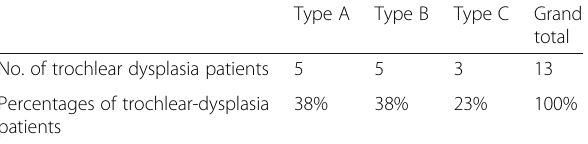
Table 10 Demonstrating the percentage of the different grades of trochlear dysplasia among the patients with patellar instability